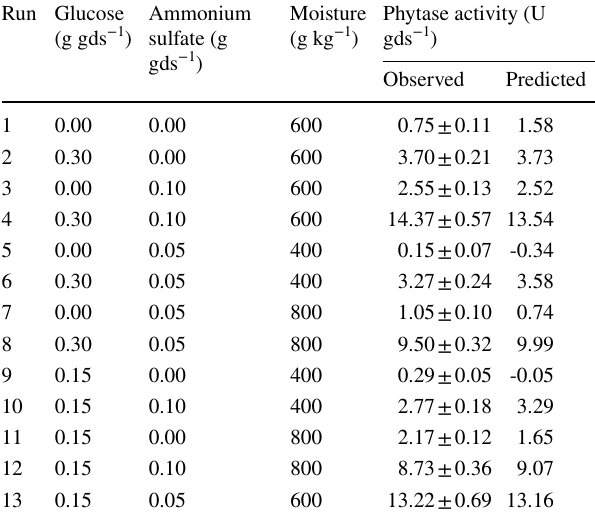
Table 2 Experimental design matrix and the results from Box– Behnken design for phytase